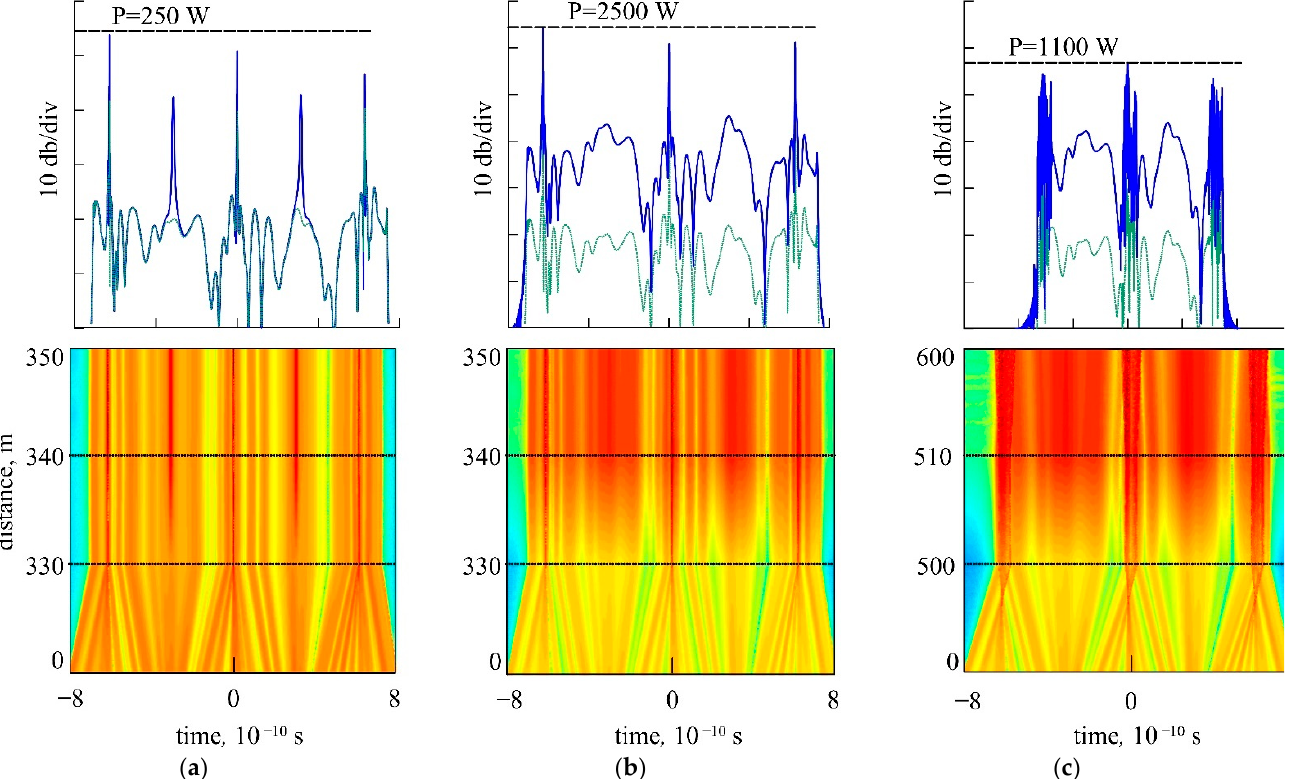
Figure 8. Pulse evolution in the fiber cascades 2–4 and pulse shapes at the system output at different length of the passive fiber (cascade 2): 330 m ( a , b ) and 500 m ( c ), the amplifier length is 10 m. The gain bandwidth is ∆ ω l = 10 12 s − 1 ( a ) and ∆ ω = 4 × 10 13 s − 1 ( b , c l